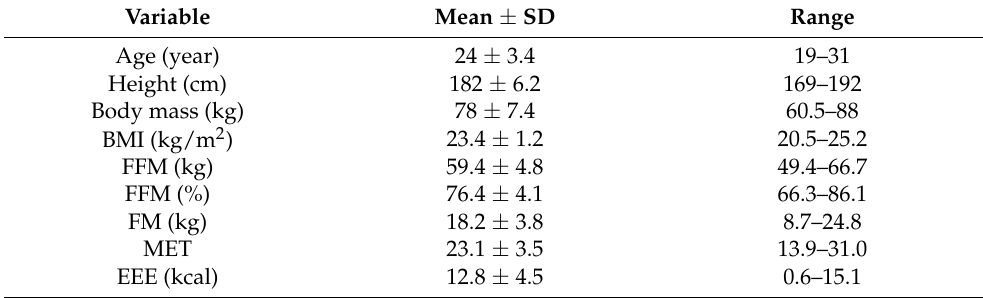
Table 1. Participant